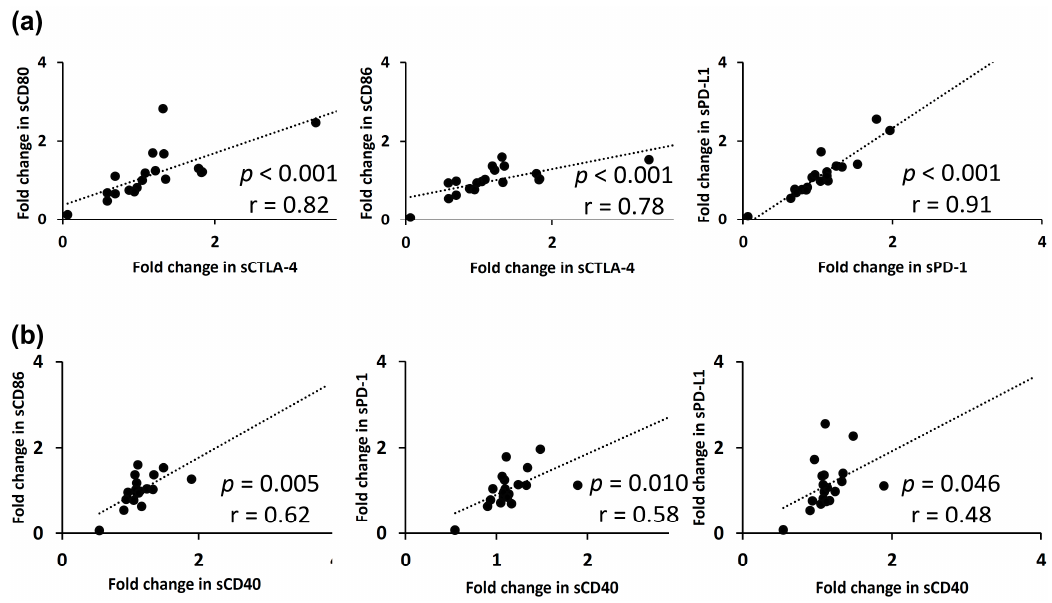
Figure 4. The relationships between fold-changes in soluble immune checkpoint protein levels in plasma at 1 week of lenvatinib treatment are presented. ( a ) A positive correlation was found between fold-changes in soluble checkpoint receptors and their ligands, including sCTLA-4 with sCD80/sCD86 and sPD-1 with sPD-L1, respectively. ( b ) sCD40 was positively correlated with some proteins in fold- changes, including sCD86, sPD-1, and sPD-L1. Spearman’s rank correlation test was used. A p -value of less than 0.05 was considered to be statistically significant.